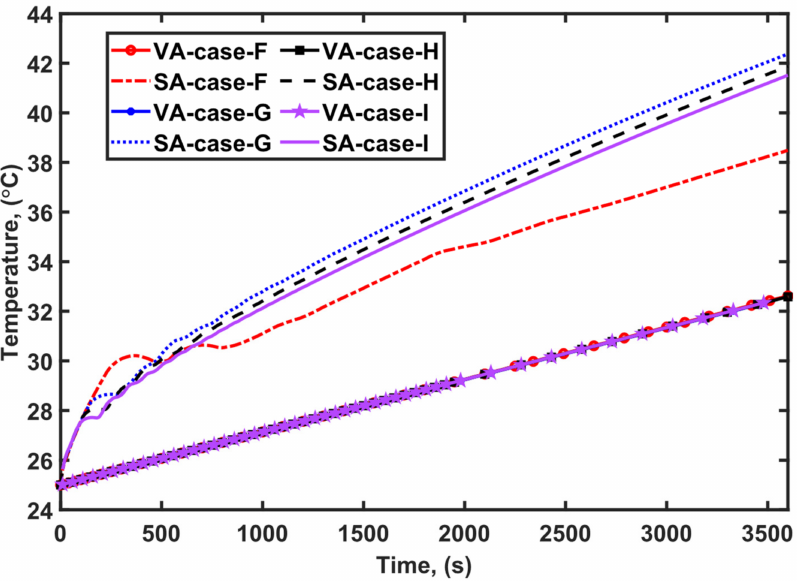
Figure 11. Temporal variation in average pool temperature and average surface temperature for one, two, three, and four heat sources (cases F, G, H, and I),